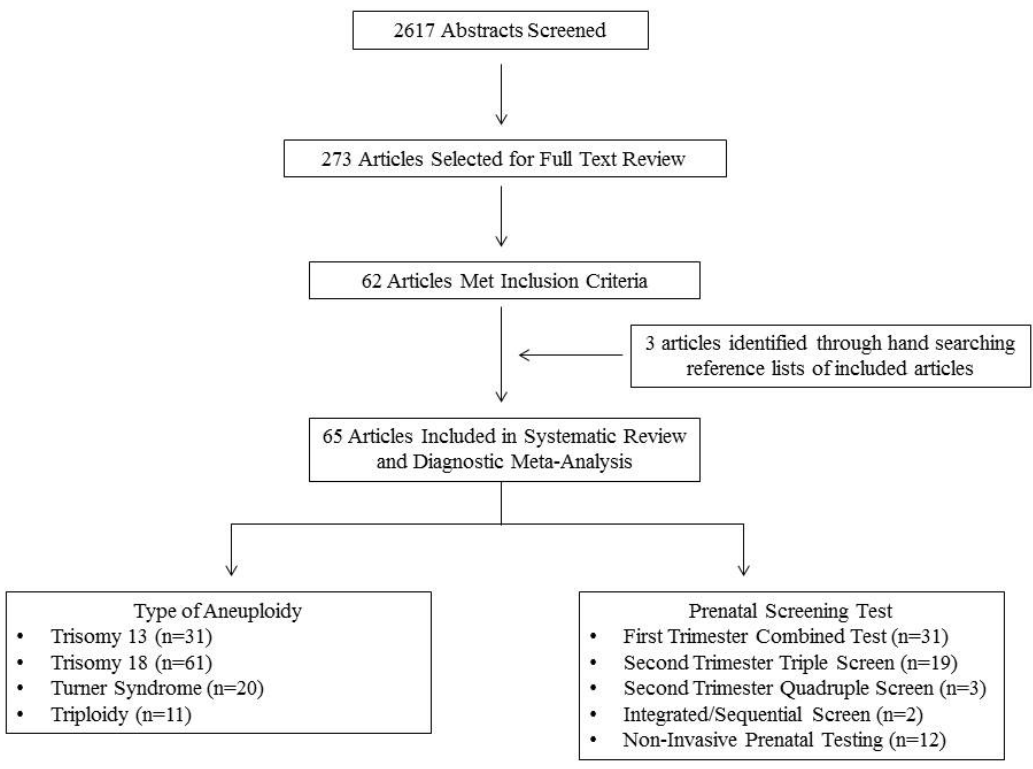
Figure 1. Flow diagram of study